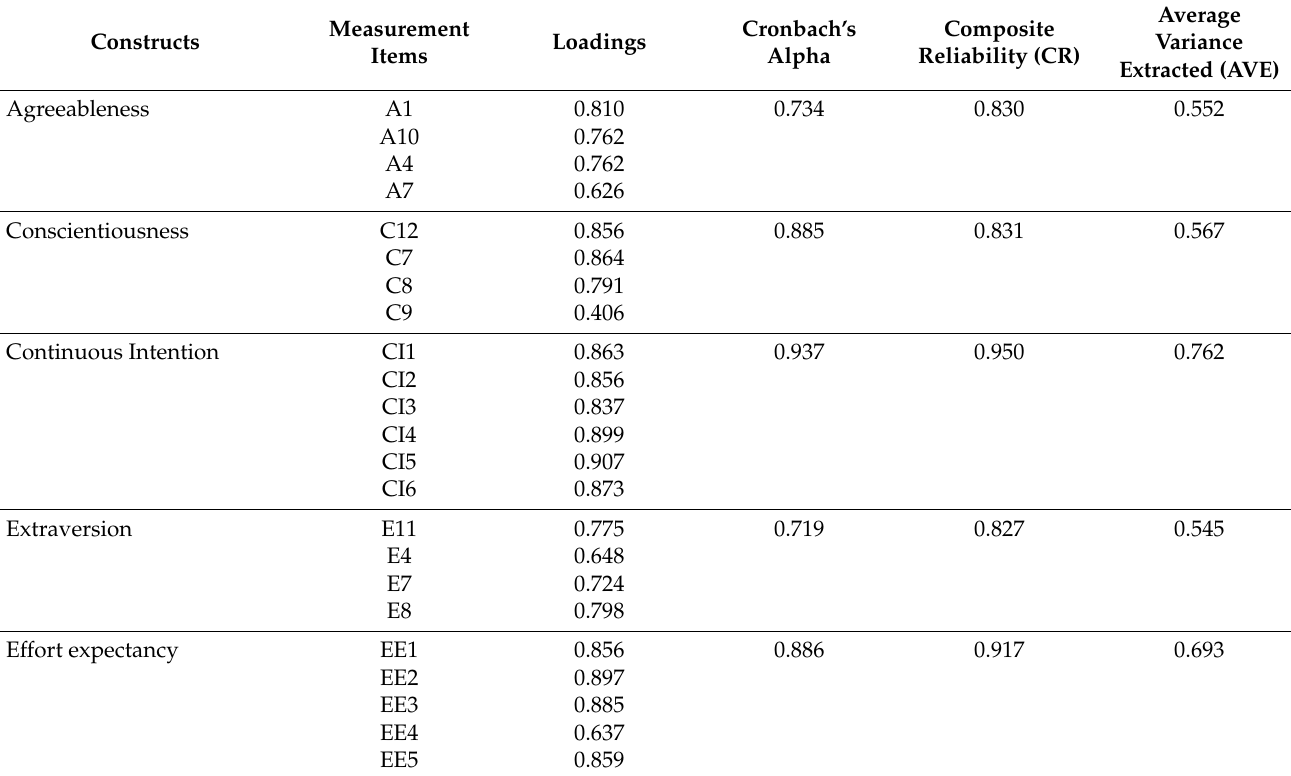
Table 3. Loadings, Composite Reliability, and Average Variance